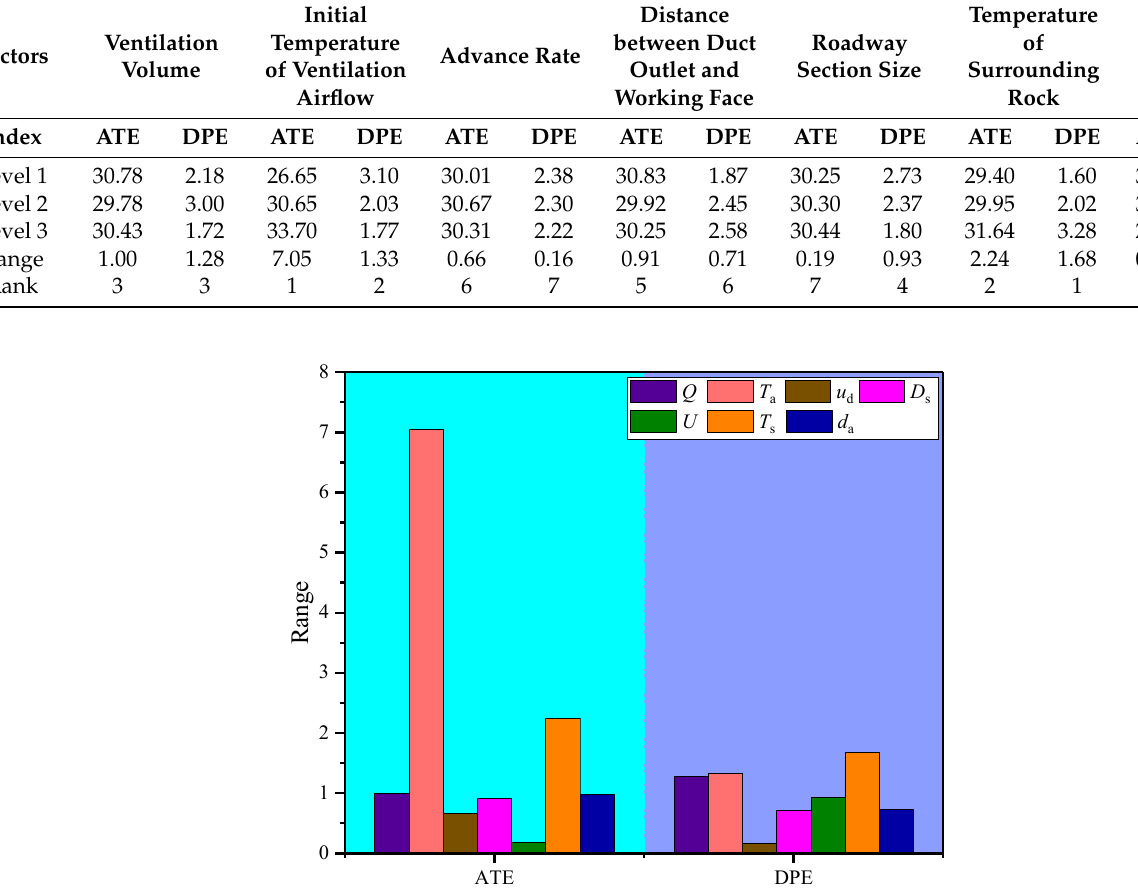
Table 3. Orthogonal test Range calculation of air temperature.